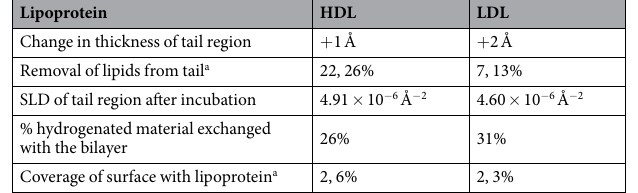
Table 2. Effects of exposure of supported DMPC/DMPS (90:10 mol%) bilayers to HDL and LDL on bilayer structure and composition. a Values for the two different supported bilayers- hydrogenated and deuterated,